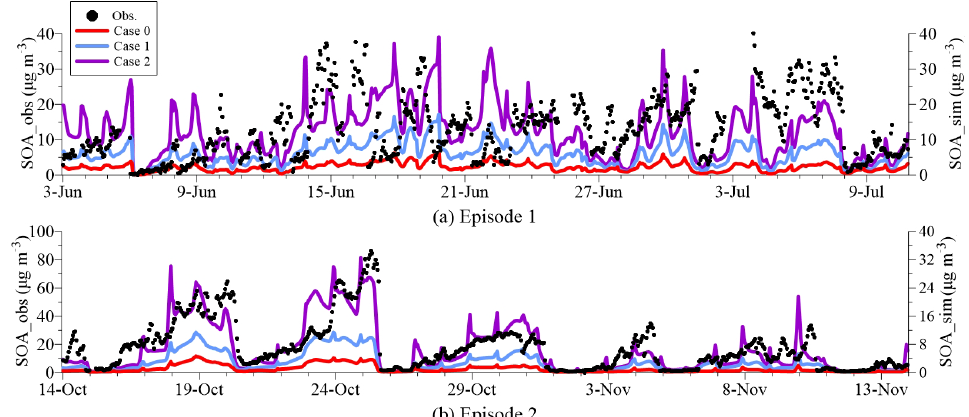
Figure 4. Hourly concentrations of the observed and simulated near-surface SOA concentrations in episode 1 (a) and 2 (b) . Case 0 is the base run, case 1 is run with the incorporation of the reactive uptake of dicarbonyls (excluding the default in-cloud dicarbonyl oxidations), and case 2 is run with the glyoxal underestimation taken into consideration based on case 1. Table 2. Performance statistics of the modeled and observed SOA concentrations (µgm − 3 ). Case Episode N C model C obs